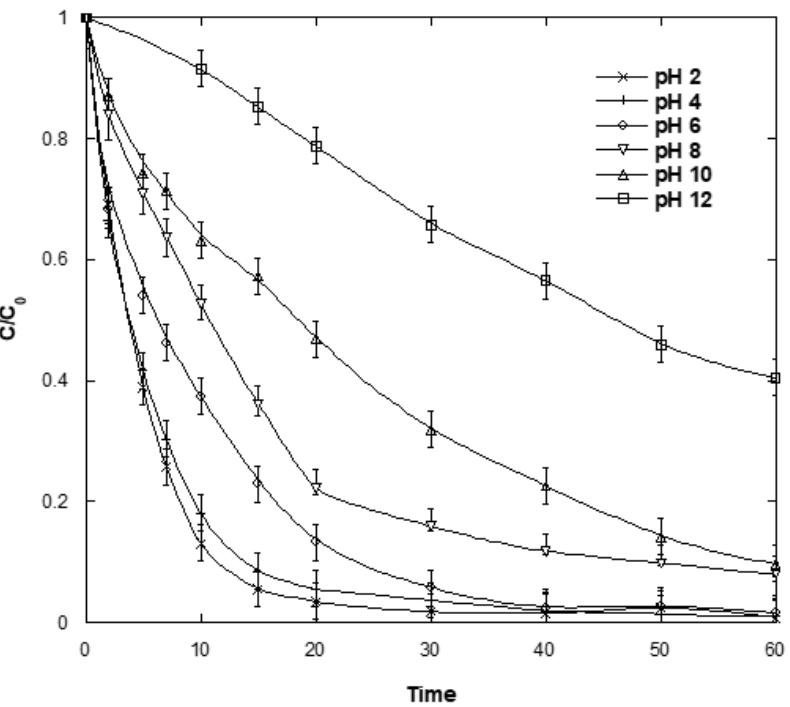
Figure 8. Effect of initial solution pH (2–12) on the removal efficiency of SO through UV/TiO 2 /IO 3 − process ([IO 3 − ] = 0.15 mM, [TiO 2 ] = 0.4 g · L − 1 , [SO] = 10 mg · L − 1 , and pH~6).